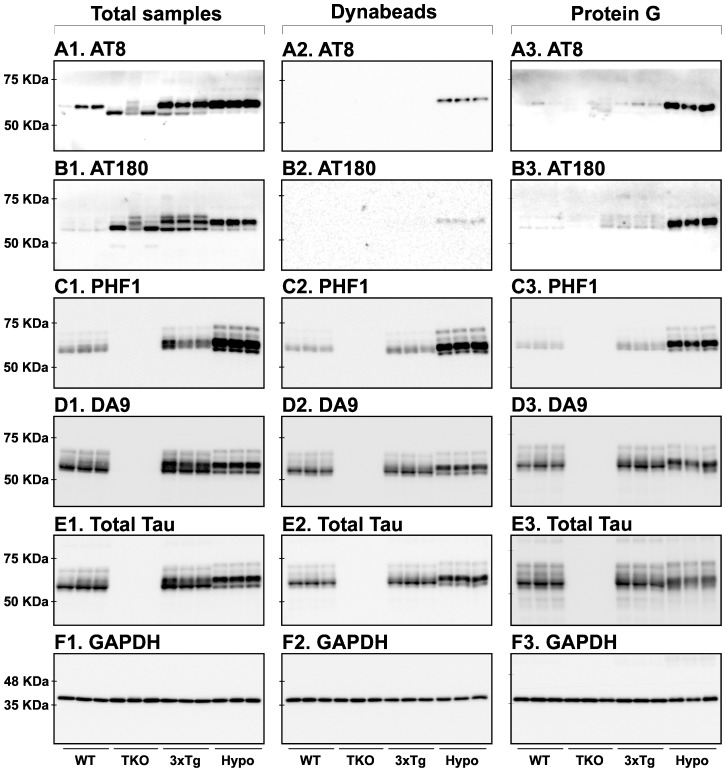
Effect of the preclearing on tau signal by Western blotting.The proteins were extracted form the cortex of 3 mouse lines: control mice (WT and Hypothermic), Tau KO mice and 3xTg mice with n = 3 for each group. The supernatant obtained from tissue homogenization was processed either in the normal manner to obtain total (non-cleared) sample (1) or processed to prepare cleared samples with Dynabeads (2) or protein G (3). Protein were extracted with SDS-PAGE and then identified with the following antibodies for both total and cleared samples: A: AT8, B: AT180, C: PHF-1, D: DA9, E: total tau, F: GAPDH. Quantifications of the blots are available in Figure S3.